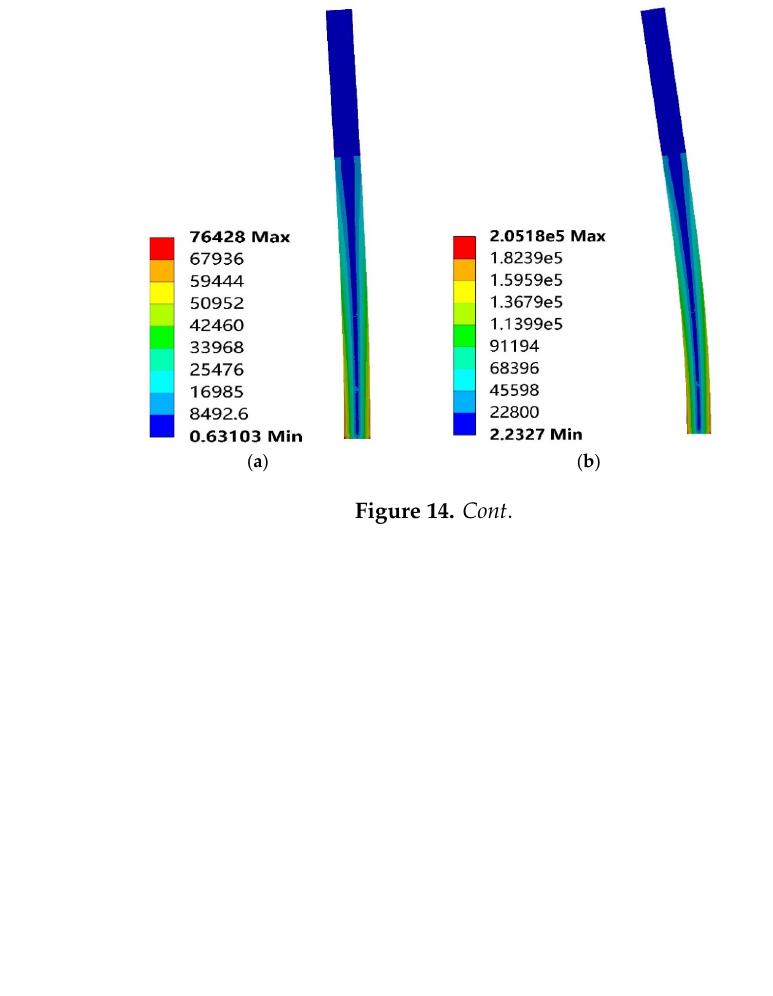
Figure 13. Deformation (m) of T-shaped flexible beam at t = 10 s ( a ) Re = 25,500, ( b ) Re = 42,500, and ( c ) Re = 59,500.